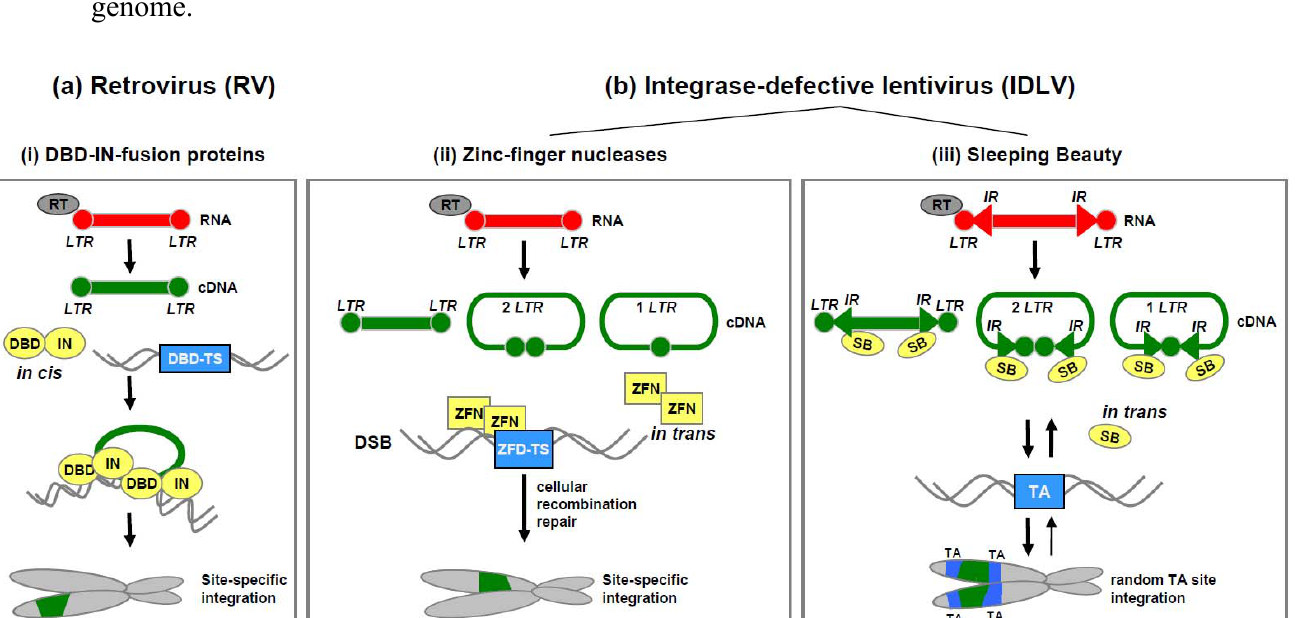
Figure 4. Strategies of retroviral integrating hybrid vector systems. Retroviral vector systems are (a) based on integrase-expressing retroviruses (RVs) or (b) on integrase- defective lentiviruses (IDLVs) as transgene delivery machineries. Retroviral RNA, flanked by long terminal repeats (LTRs) is reverse transcribed to cDNA by the reverse transcriptase (RT) in the host cells. The transgene insertion occurs like indicated in the scheme (i-iii). (i) Retroviral vectors express integrase (IN) proteins in cis , which are fused to specific DNA-binding domains (DBD) and trigger insertion in specific DBD target sites (TS) in the genome. (ii) For site-specific targeting of the transgene, which is delivered by IDLVs, zinc-finger nucleases (ZFN) are utilized. The zinc-finger-domain (ZFD) of the ZFN binds to the zinc-finger domain target site (ZFD-TS) and mediates double strand breaks (DSB) at this specific site in the genome. Subsequently, the transgene is integrated and the DNA repaired. (iii) Hybrid vectors based on IDLVs harbour recognition sites (inverted repeats, IRs) for Sleeping Beauty (SB) transposase binding. The viral cDNA can form a linear structure with 2-LTR motifs or circular formations with 2 LTRs or 1 LTR. SB expressed in trans mediates the insertion of the transgene into TA sites of the host